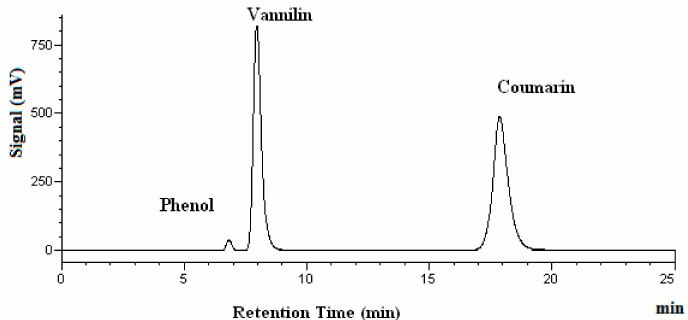
Figure 2. Chromatograms of vanillin and coumarin in a standard solution. Phenol was used as the internal standard.